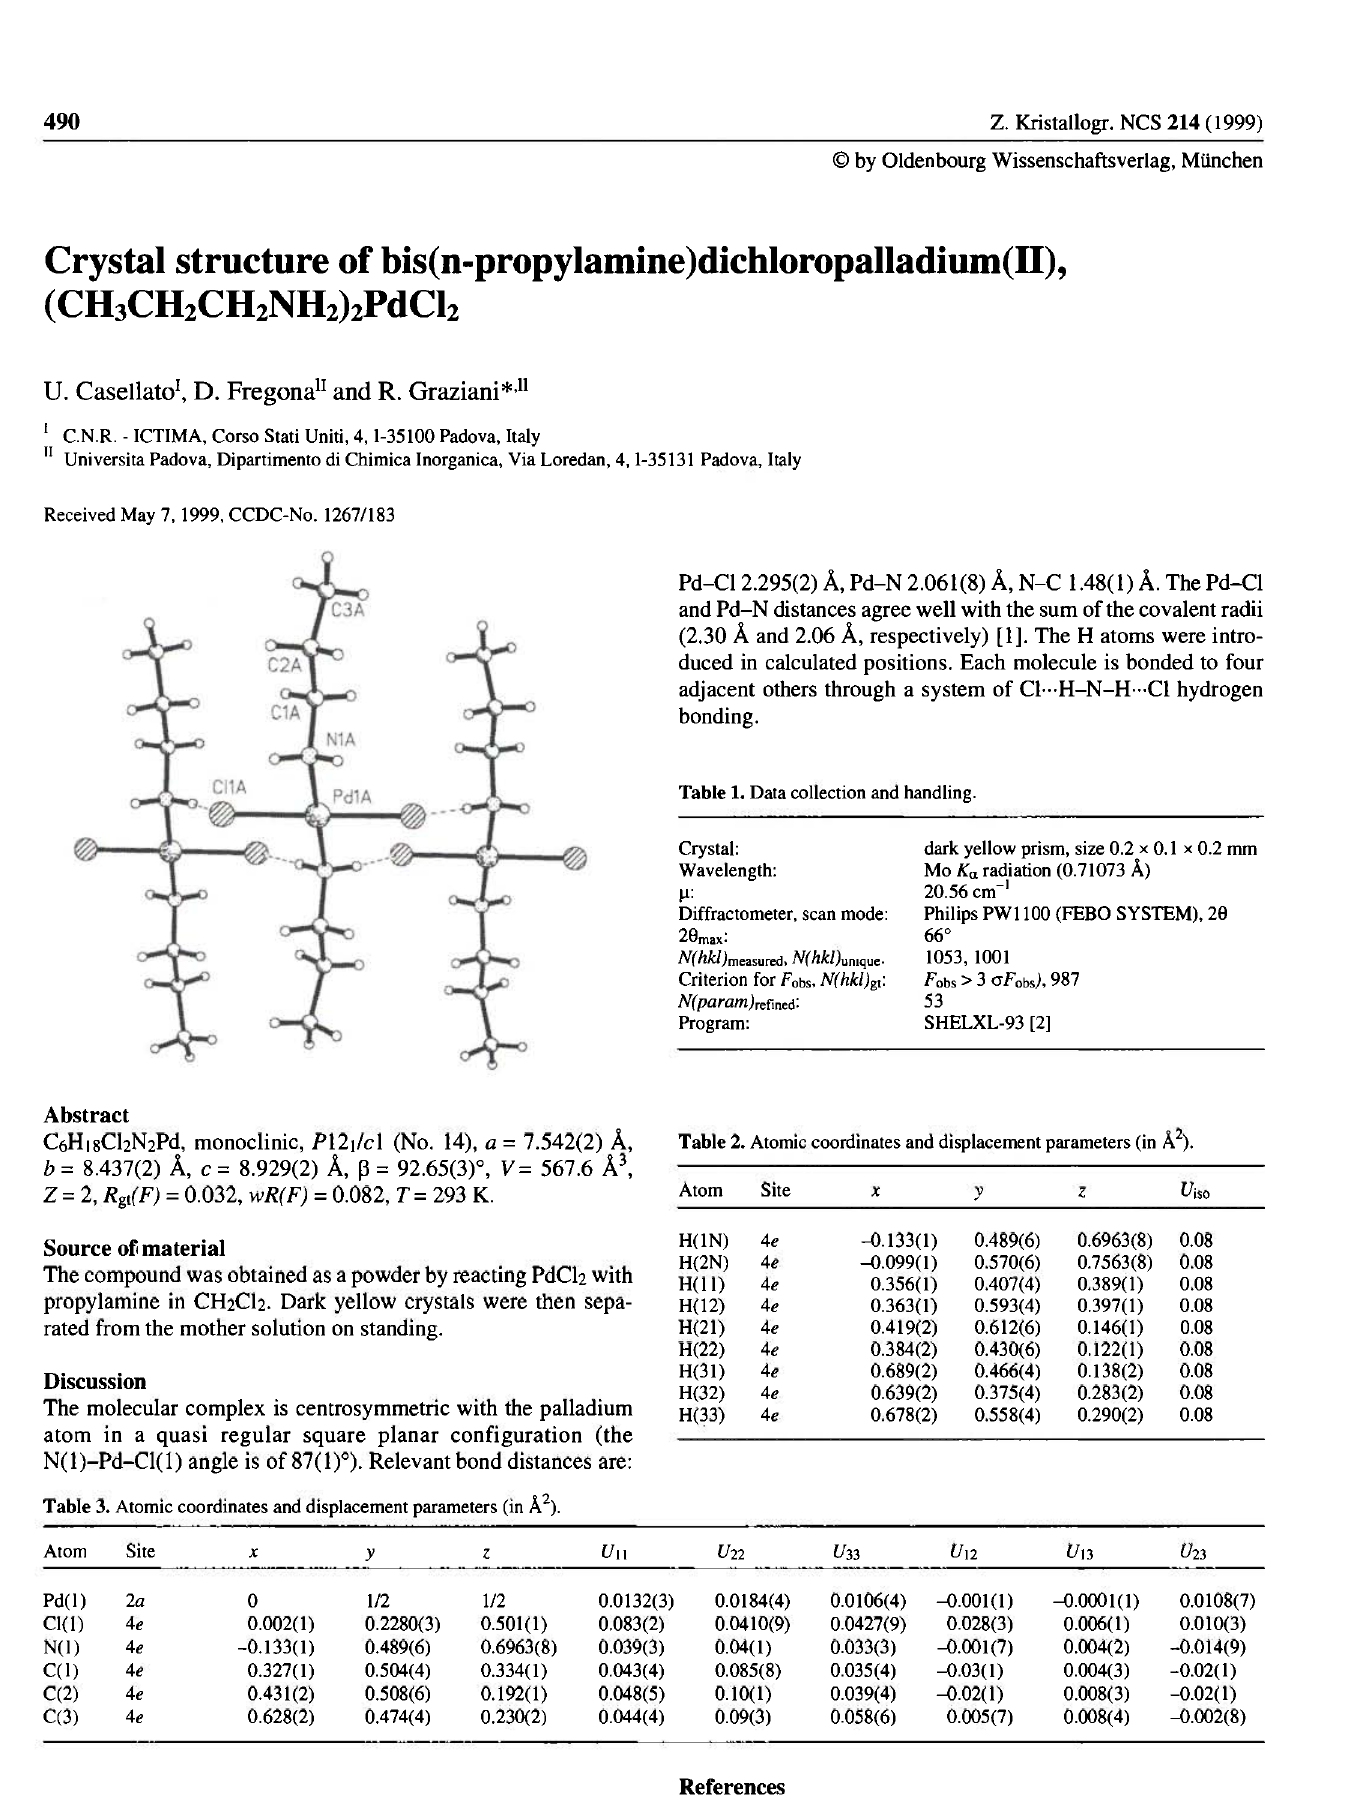
Table 3. Atomic coordinates and displacement parameters (in Ä 2 ).